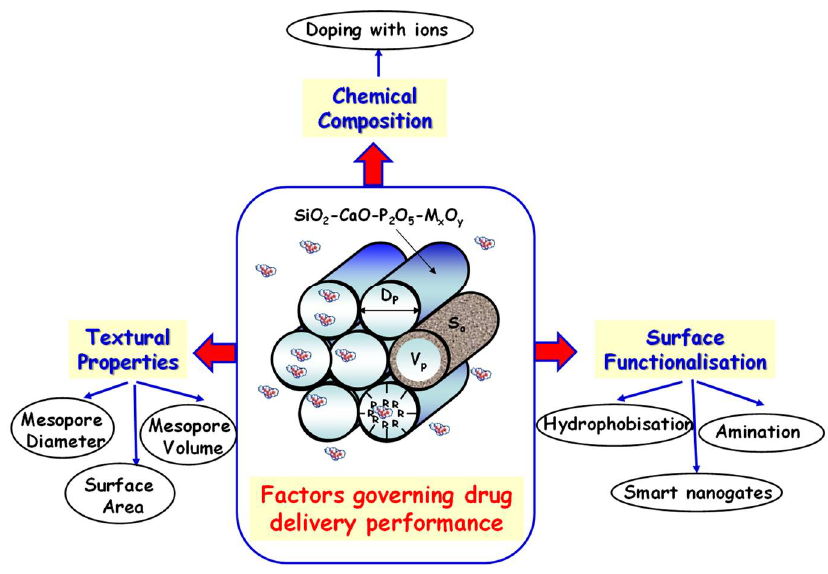
Figure 8. Pivotal factors that govern the performance of MBGs as drug delivery systems. Reproduced (adapted) from reference [21]. Copyright 2021 MDPI.